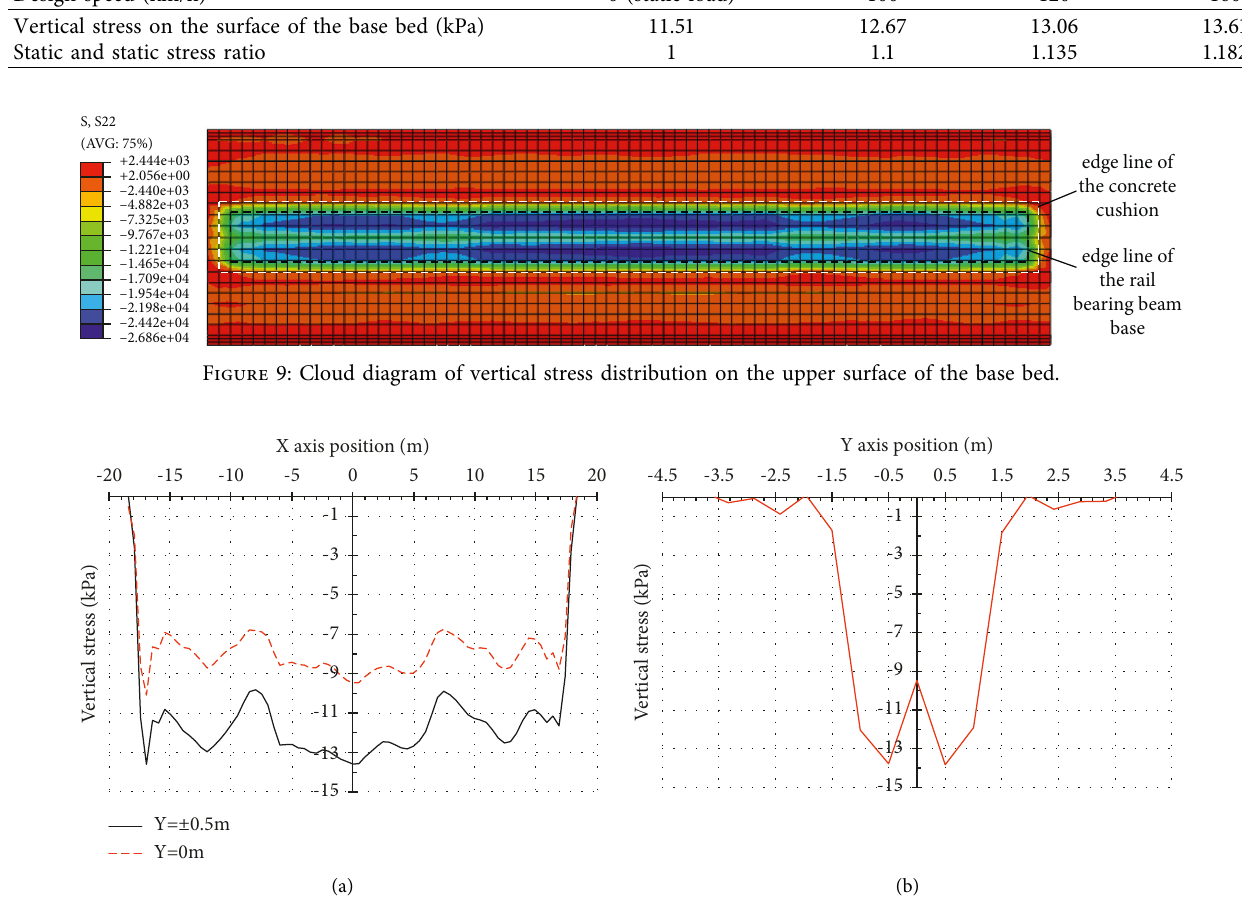
Figure 10: Curve of vertical stress distribution on the upper surface of the bed surface: (a) distributed along the X -axis (longitudinal); (b) distributed along the Y -axis